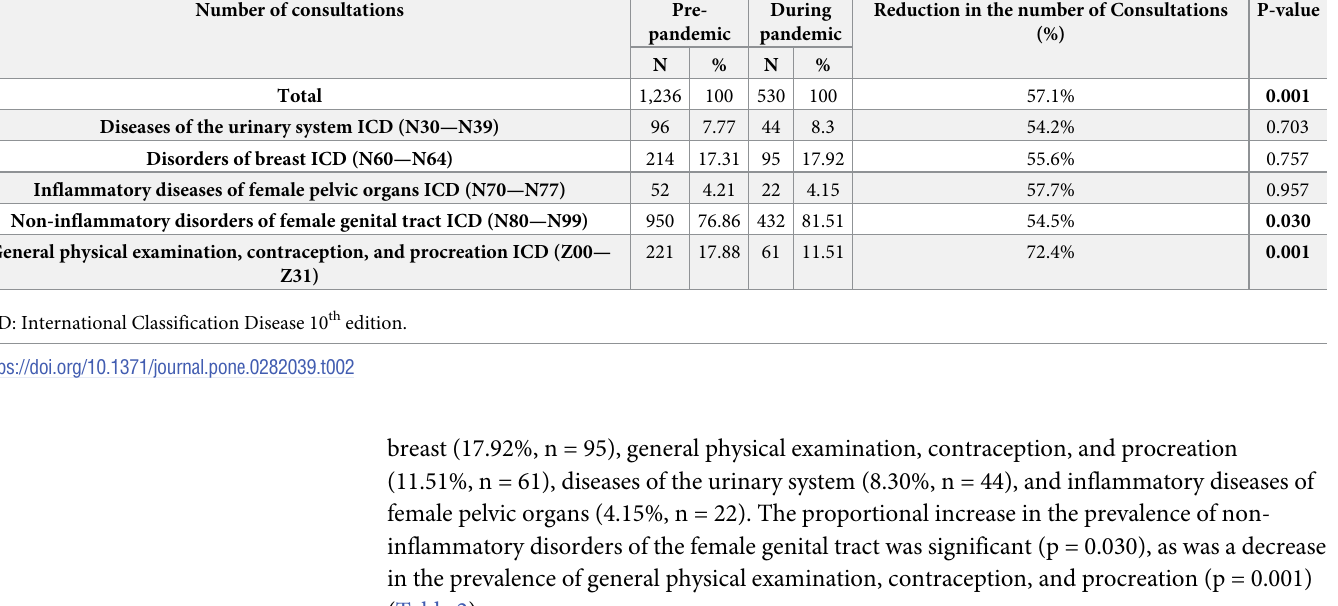
Table 2. Prevalence of non-oncological gynecological diagnoses and the reduction of consultations pre- and during